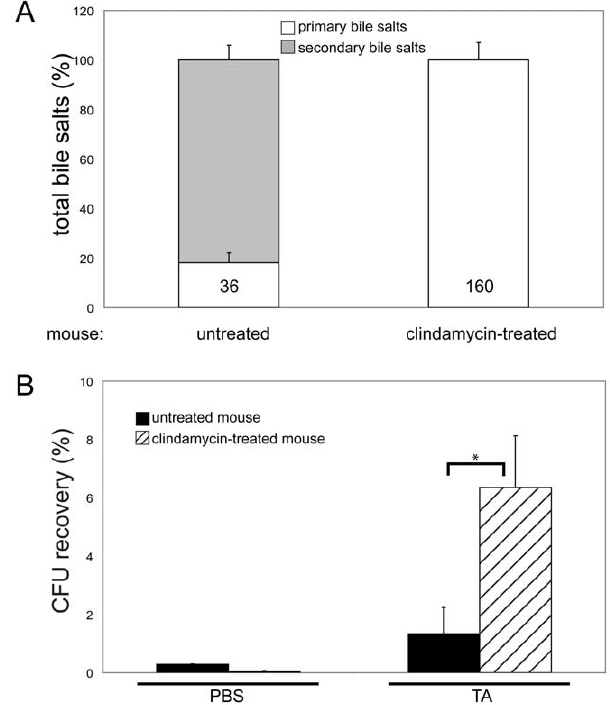
Figure5.Modificationof taurocholatebycecal floraanditsability to stimulate CFU recovery from spores. Contents of the ceca from freshly euthanized, clindaymin-treated (striped bars) or untreated (black bars) mice were isolated under anaerobic conditions, washed 5 times to remove any bile salts present, and incubated with 0.1% taurocholate for 24 hours at 37 u C. Samples were pelleted, and the supernatant was boiled and used in A ) bile salt quantitation and B ) CFU recovery assays. The CFU/ ml were compared to the CFU/ml recovered from spores incubated with taurocholate, which was considered 100% germination. Data are the mean of at least three experiments, with error bars representing the standard error of the mean. (* p , 0.05, Student’s t-test).